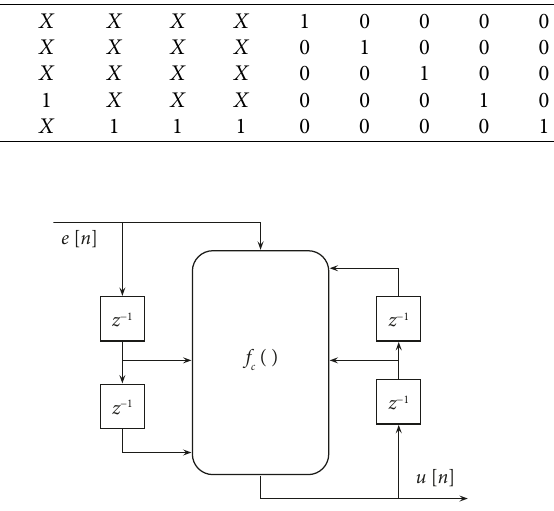
Figure 7: Input and output configuration used for the controller.